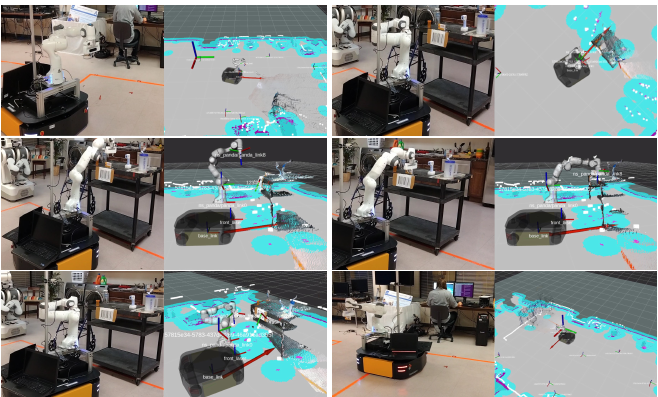
Figure 11. ( Top left ) Robot moving from home position to Anchor 1 waypoint. ( Top right ) Robot moving from Anchor 1 waypoint to Anchor 2 waypoint. ( Middle left ) Robot getting into pre-grasp position. ( Middle right ) Robot grasping the object. ( Bottom left ) Robot getting into post-grasp position. ( Bottom right ) Robot moving to home position.